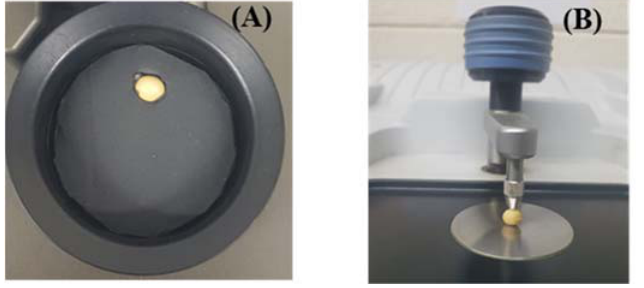
Figure 1. The photograph of the bean seed spectral data acquisition of FT-NIR ( A ) and FT-IR ( B